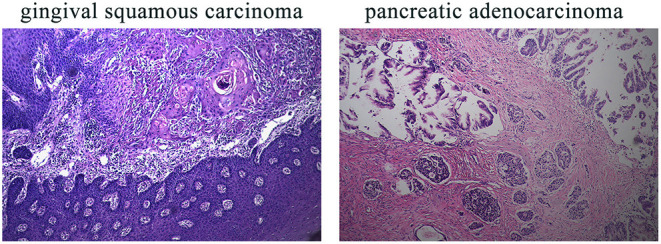
IHC results of the patient's gingival squamous carcinoma and pancreatic adenocarcinoma. IHC, immunohistochemistry. Magnification for all images: 20×.